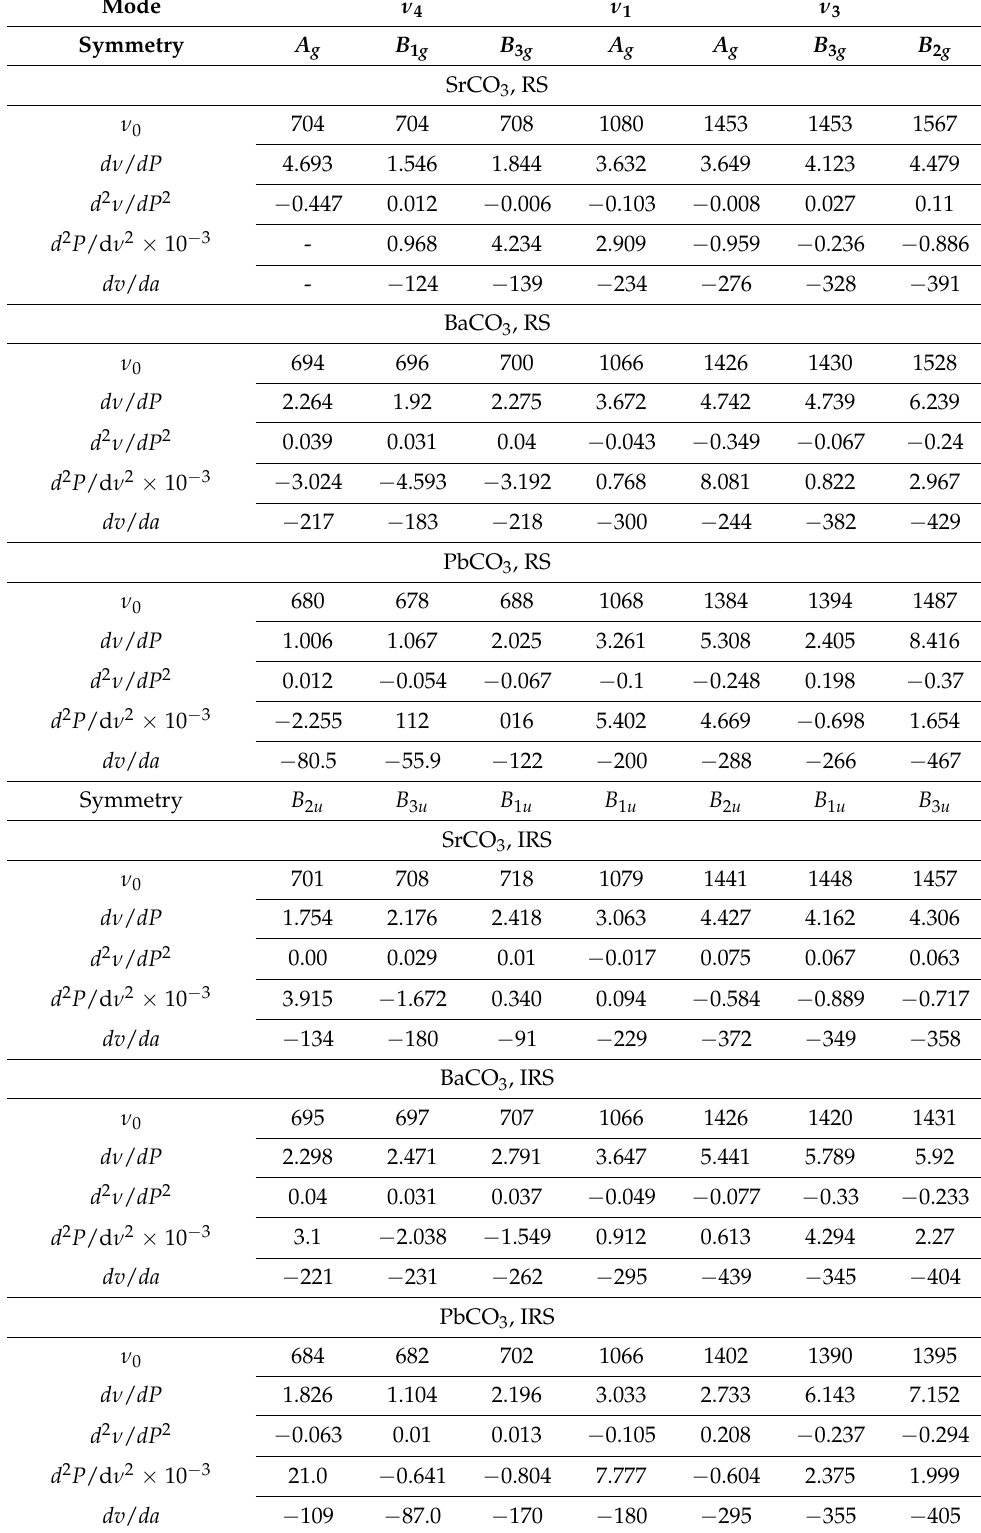
Table 6. Wavenumbers ν 0 (cm − 1 ) of the v 4 , v 2 , v 1 and v 3 intramolecular modes of carbonates with the aragonite structure; their first d ν / dP (cm − 1 /GPa) and second d 2 ν / dP 2 (cm − 1 /GPa 2 ) P pressure derivatives; the second pressure derivative d 2 P / d ν 2 (GPa 2 /cm − 1 ), with respect to the